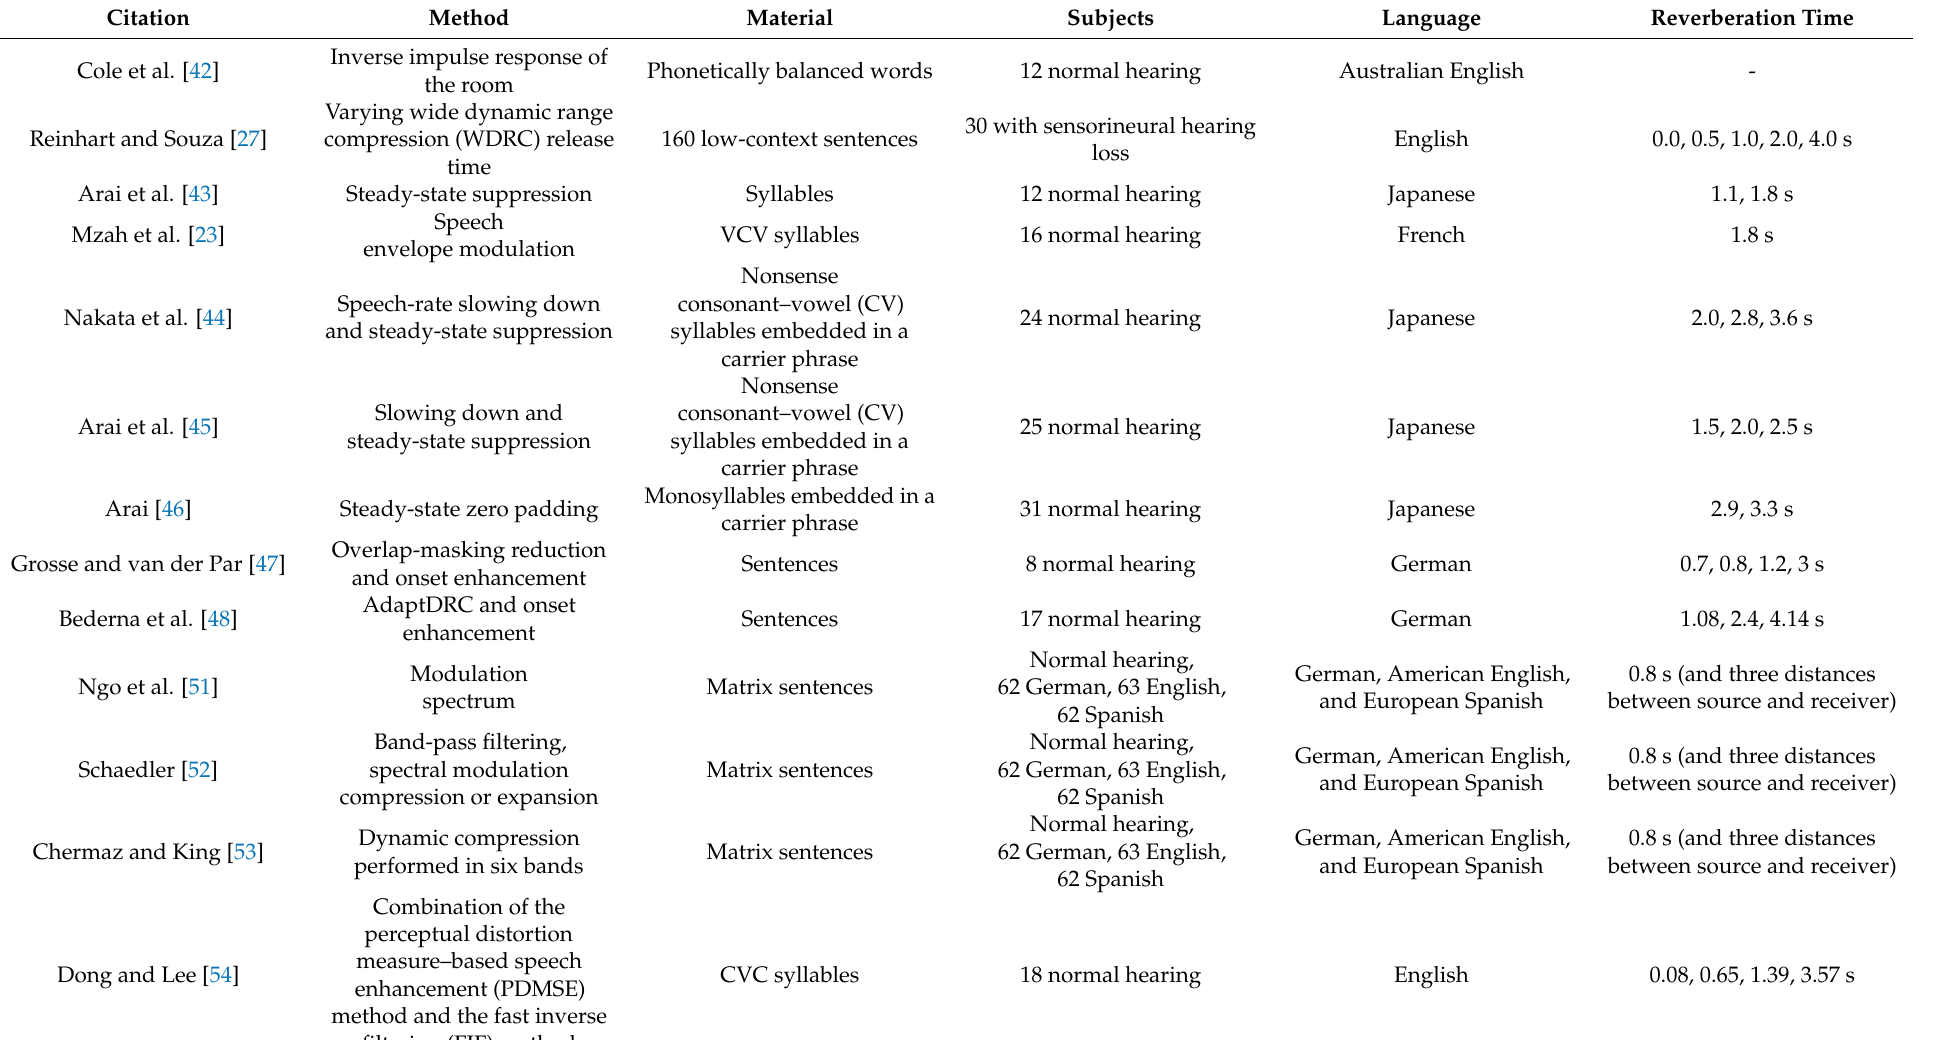
Table 1. Summary of methods designed to improve speech intelligibility under reverberant